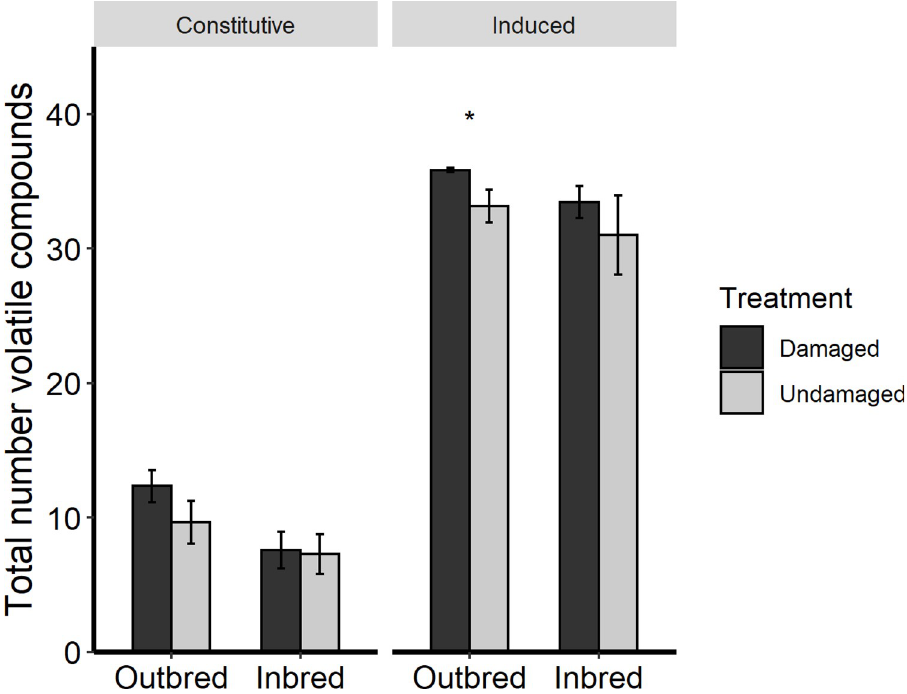
Fig 3. Total number of volatile organic compounds in the constitutive and induced blends of S . carolinense offspring from herbivore-damaged and undamaged, inbred and outbred maternal parents. Asterisks ( � ) indicate significant differences among treatments determined by Wilcox signed-rank test ( P < 0.05). Error bars correspond to standard errors.